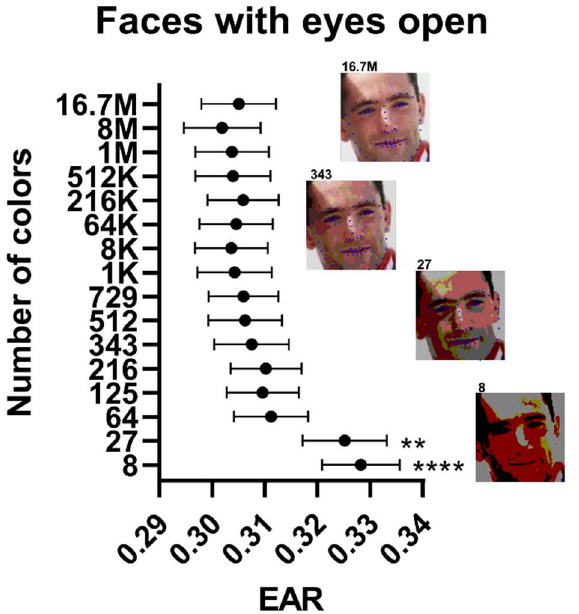
Figure 2. Palpebral fissure dimensions and model performance in the open-eyes dataset as a function of image quality using the Closed Eyes in the Wild Dataset. Data points are eye aspect ratio (EAR) estimates as a function of image color depth. Inserts show images at different color depths with overlaying model prediction. Data points ± error represent mean value ± SEM. Statistical significance levels were for one-way ANOVA with multiple comparisons using images of the best quality as the comparator. EAR: Eye aspect ratio. ** : p < 0.01; *** : p < 0.001; **** : p < 0.0001.